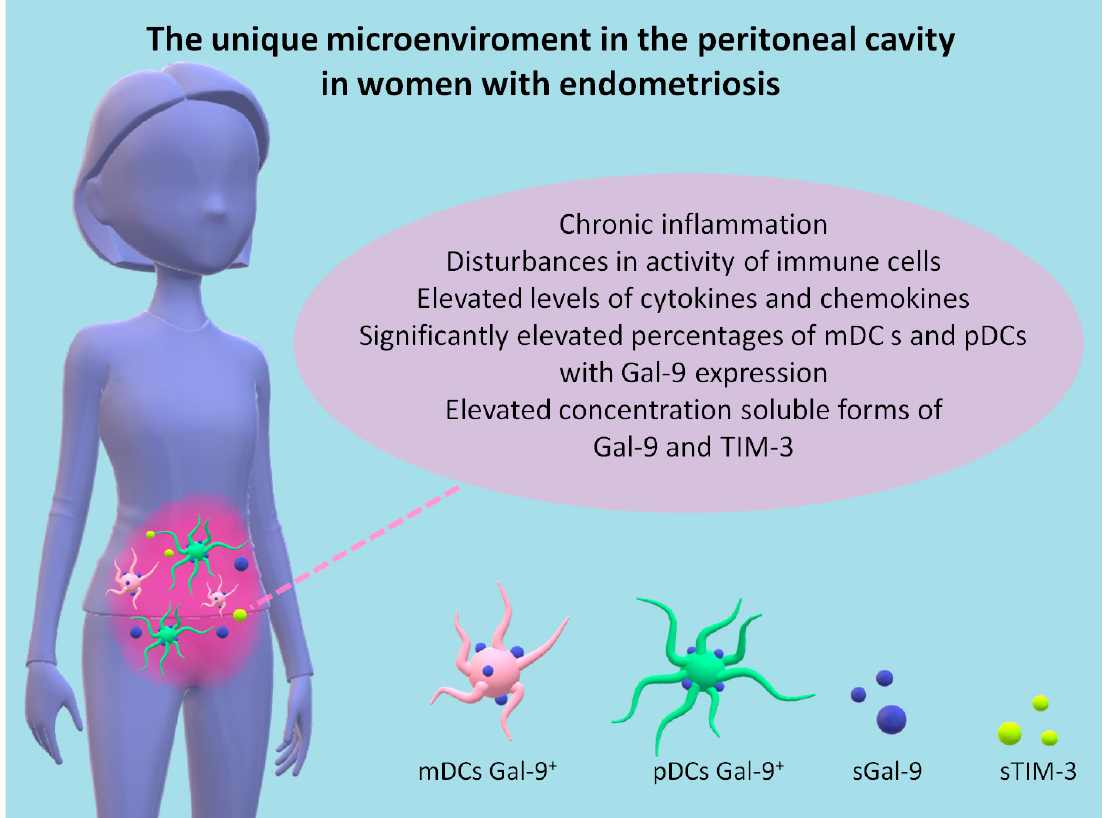
Figure 10. The unique microenvironment in the peritoneal cavity in women with endometriosis.